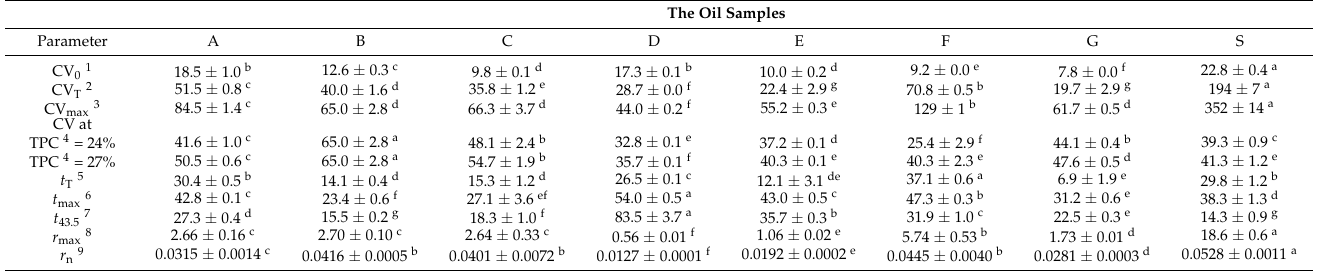
Table 2. The parameters resulting from the sigmoidal changes (Equation (3)) of carbonyl value (CV) over the frying time ( t , h) at 170 ◦ C for the oil samples A–S. The Oil